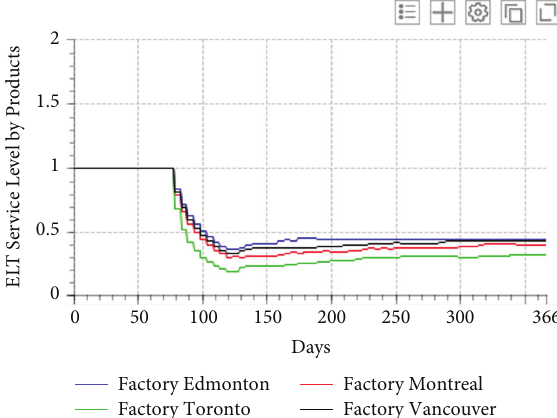
Figure 6: ELT service level by products (per source).